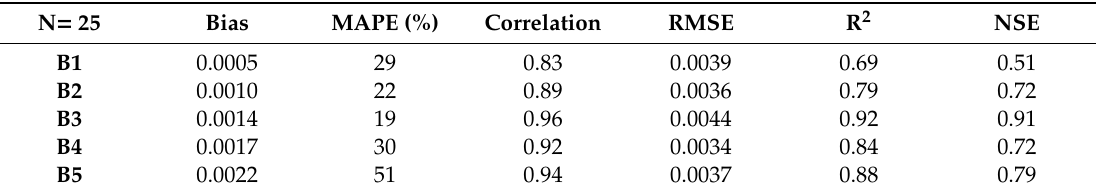
Figure 3. Comparison between in situ and MSI reflectances after atmospheric correction. The dashed line indicates the y = x, the solid lines (red and green) show the best-fits and the vertical error bars represent the standard deviations corresponding to the four selected pixels. Table 3. Statistical indicators between the measured and satellite-derived water reflectance for the 6SV method.